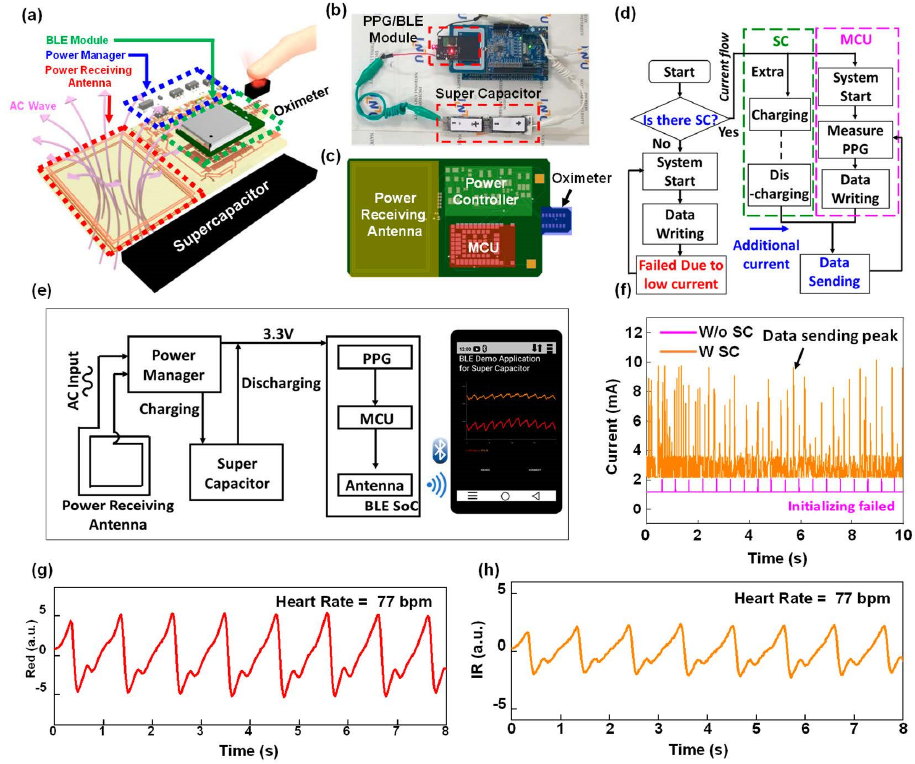
Figure 7. Design and characterization of wireless powered BLE/PPG module. Illustration ( a ), PCB design ( b ), and real image of a wireless powered device with supercapacitor for temporary power storage ( c ), current flow chart of system, ( d ) system block diagram of device, ( e ) current consumption characterization of BLE/PPG module with or without supercapacitor, ( f ) measured pulse signals from the device placed on the index finger with ( g ) red LED and ( h ) IR LED.